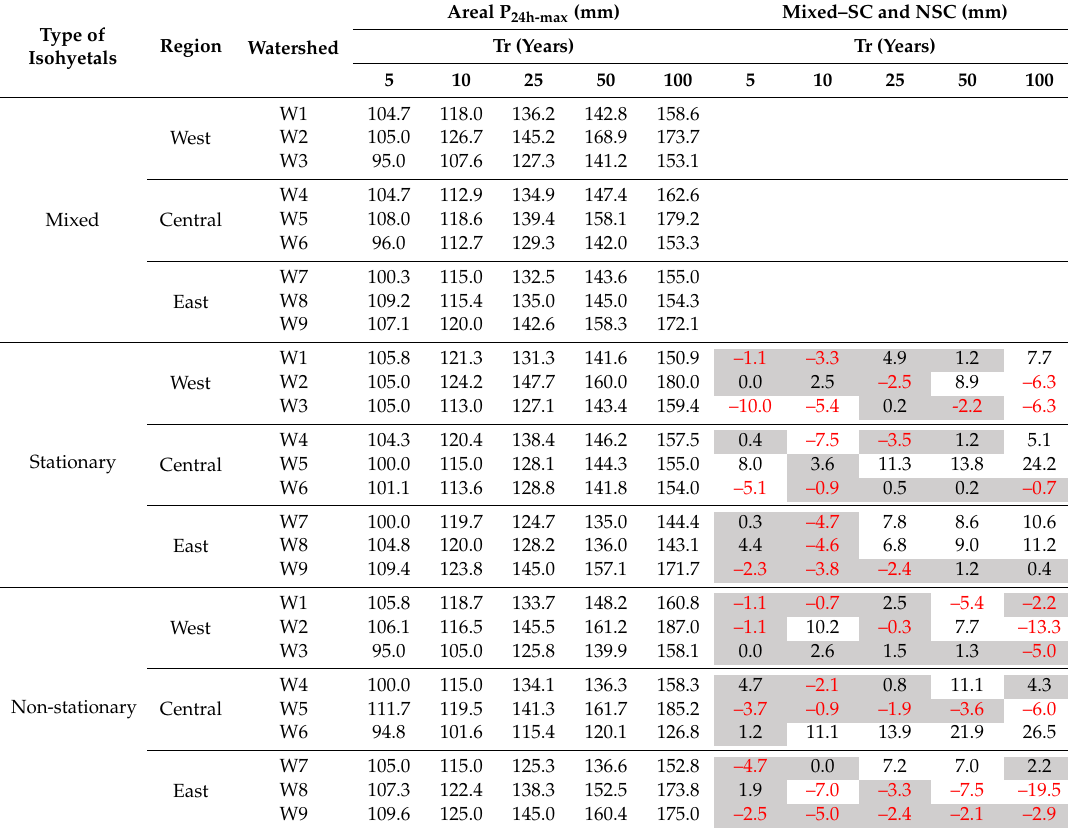
Table 10. P areal values for di ff erent isohyetal maps. Tr—return period. Type of